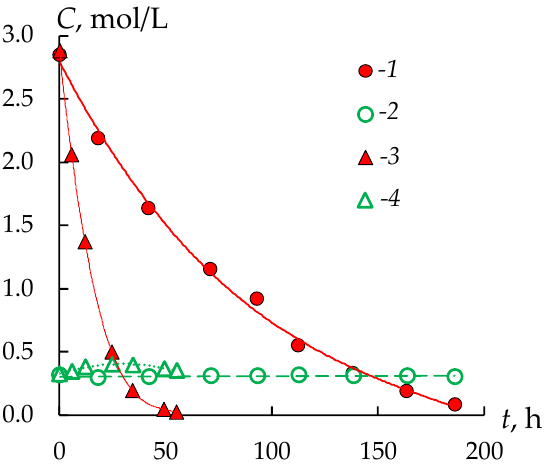
Figure 4. Kinetic dependence of the concentrations of sulfuric acid (1, 3) and nickel sulfate (2, 4) in the processed solution during the DD process with the MA-41 membrane (1, 2) and TWDDA3 one (3, 4).